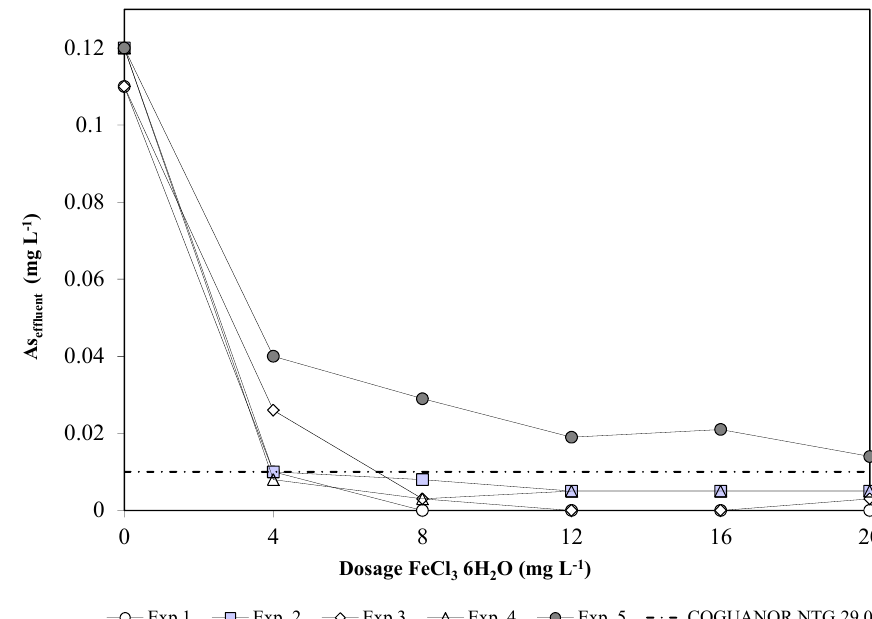
Figure 5. Influence of FeCl concentration 0.11–0.12 mg·L − 1 ( n =